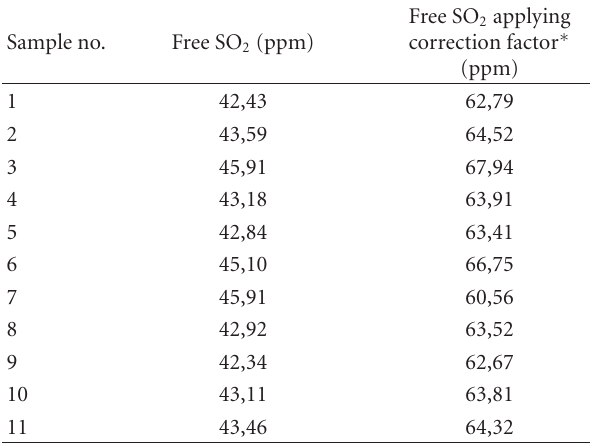
Table 1: Free SO 2 concentration determined by the Monier- Williams modified method using 1L min − 1 air